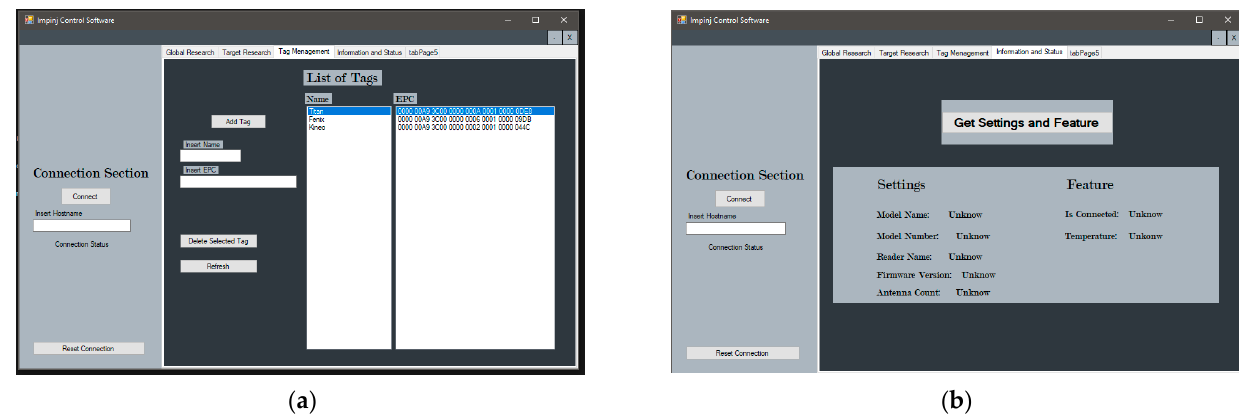
Figure 8. User interface: ( a ) database interrogation; ( b ) reared connection and monitoring status.